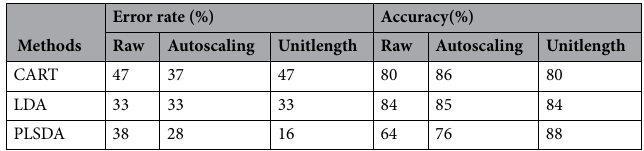
Table 4. The cross validation results of botanical origin identification based on electronic